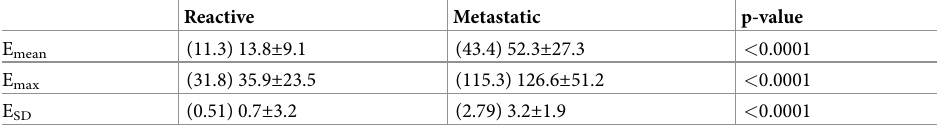
Table 1. Summary of CUSE measurements in reactive and metastatic axillary lymph